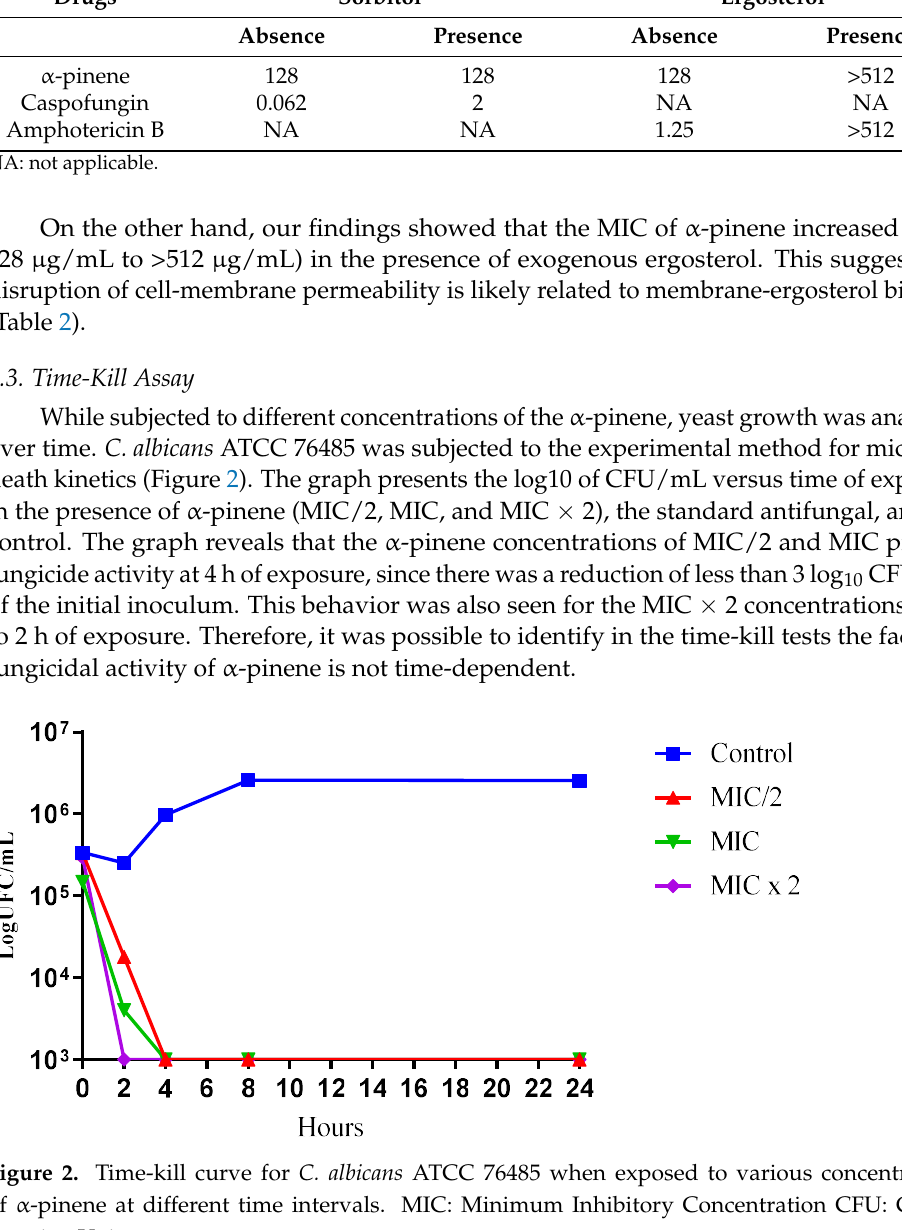
Figure 2. Time-kill curve for C. albicans ATCC 76485 when exposed to various concentrations of α- pinene at different time intervals. MIC: Minimum Inhibitory Concentration CFU: Colony Forming